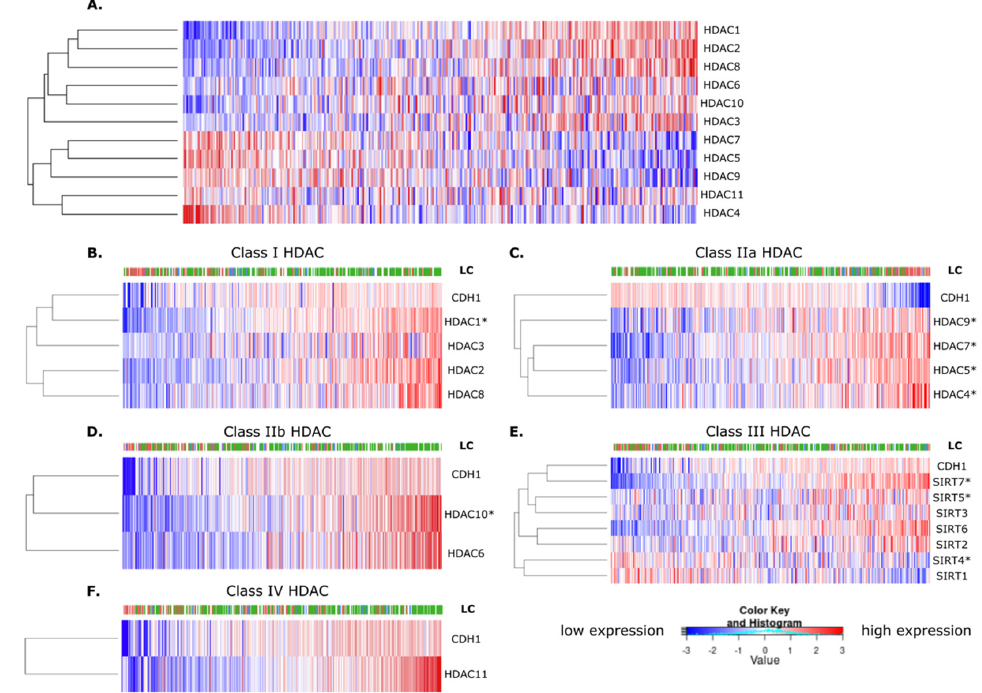
Figure 1. TCGA and STAD database highlight the correlation between HDACs and CDH1 expres- sion. The relationship between HDAC classes and CDH1 expression from the Cancer Genome Atlas (TCGA) and the Stomach Adenocarcinoma (STAD) database was analyzed and the Spearman cor- relation was calculated between each HDAC and CDH1 (detailed values in Table S4). A low expres- sion is represented in blue, and a high expression in red. ( A ) Hierarchical clustering of zinc and NAD+-dependent HDACs. Correlation between HDACs and CDH1 for ( B ) Class I HDAC (HDAC1, HDAC2, HDAC3 and HDAC8), ( C ) Class IIa HDAC (HDAC4, HDAC5, HDAC7 and HDAC9), ( D ) Class IIb (HDAC6 and HDAC10), ( E ) Class III HDAC (Sirtuins) and ( F ) Class IV HDAC (HDAC11). The HDACs with a significant correlation with CDH1 expression are labeled with an asterisk (*). LC = Lauren Classification, representing the different gastric cancer subtypes: red, diffuse; green, intes- tinal; and blue, mixed subtypes.